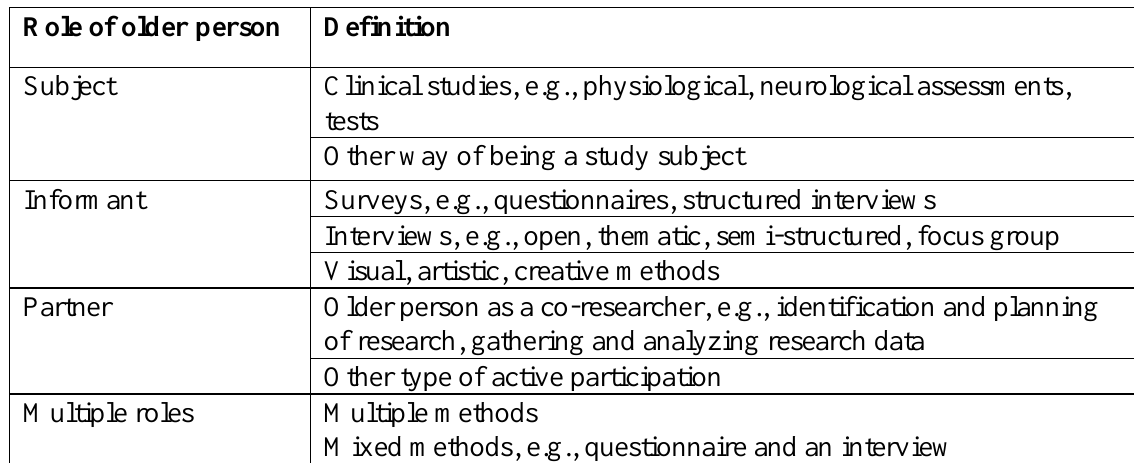
Table 1. Roles of older people in learning studies (authors' own analysis) Role of older